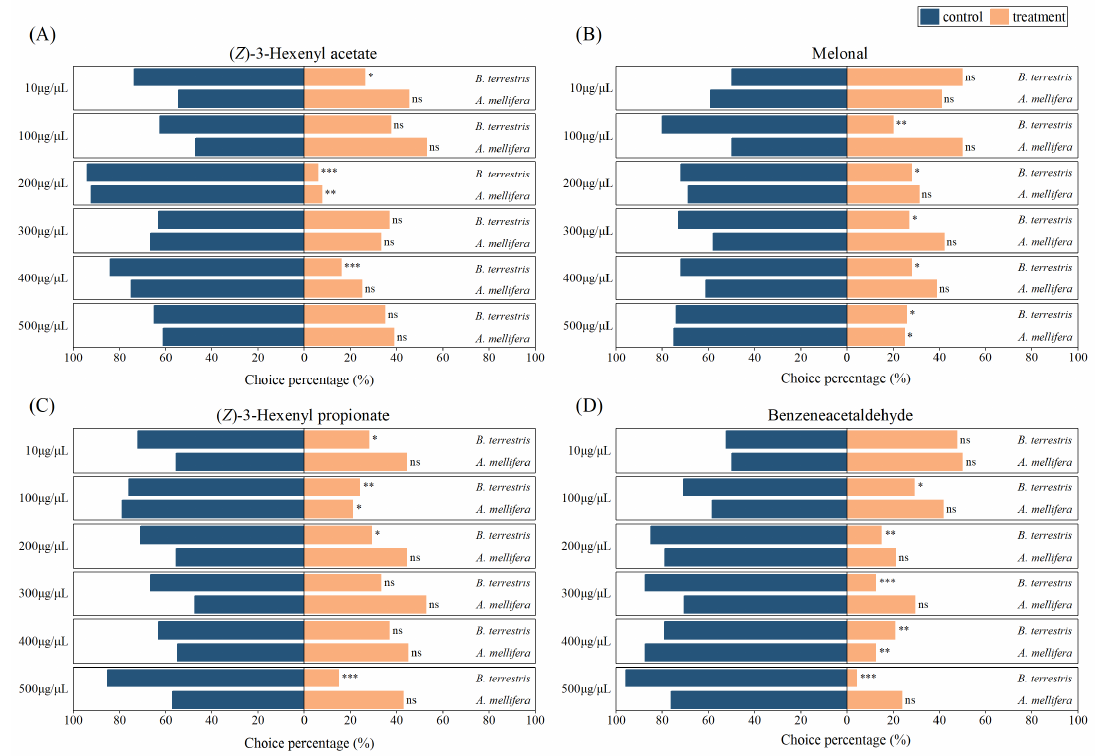
Figure 4. Difference in behavior choices of bees to different compounds at six concentrations: ( A ) the behavior choice of bees to ( Z )-3-hexenyl acetate; ( B ) the behavior choice of bees to melonal; ( C ) the behavior choice of bees to ( Z )-3-hexenyl propionate; ( D ) the behavior choice of bees to benzeneacetaldehyde. (ns: p > 0.05; * 0.01 < p < 0.05, ** 0.001 < p < 0.01, and *** p < 0.001).